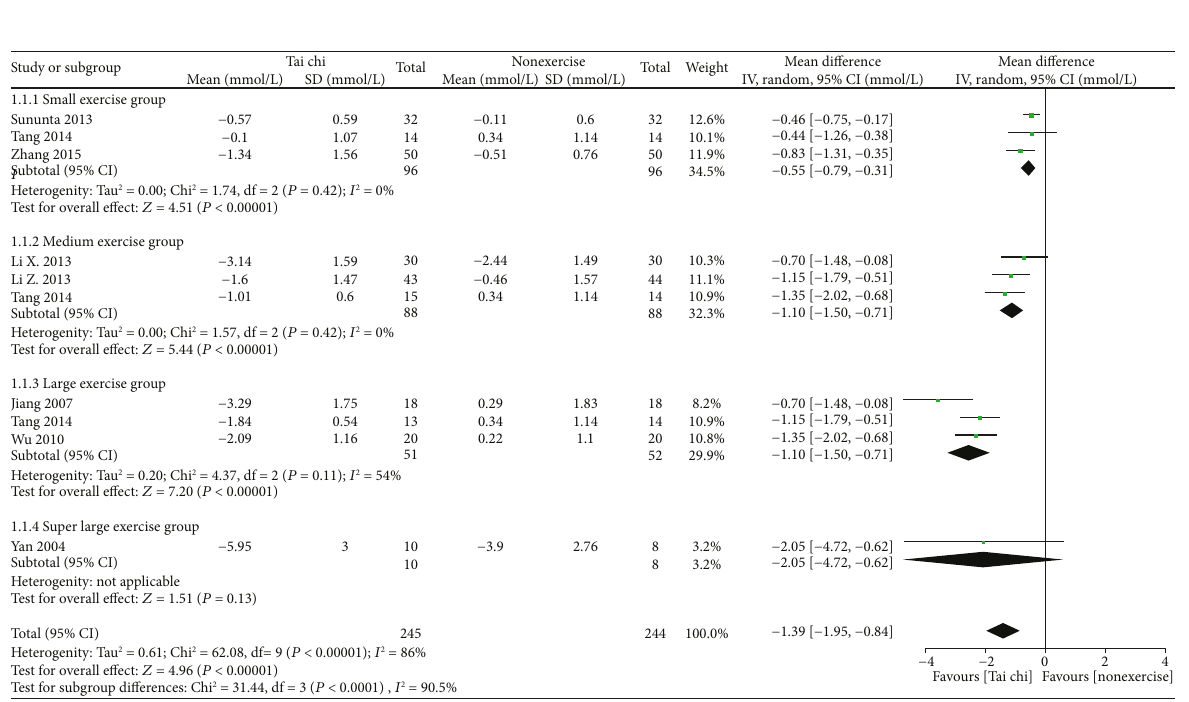
Figure 2: The meta-analysis for comparing FBG between Tai chi and the nonexercise. CI: con fi dence interval; SD: standard